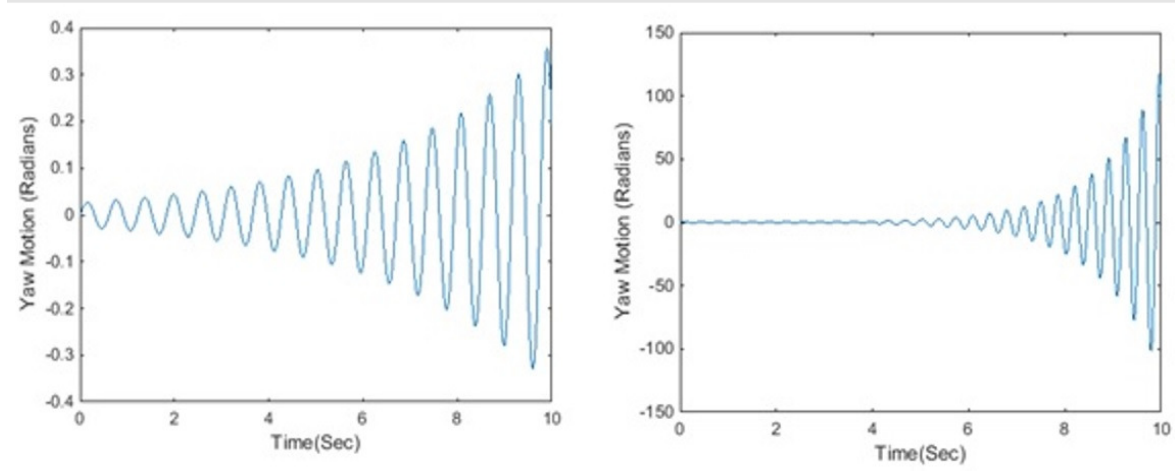
Fig. 3: Step response of Unconstrained Wheelset